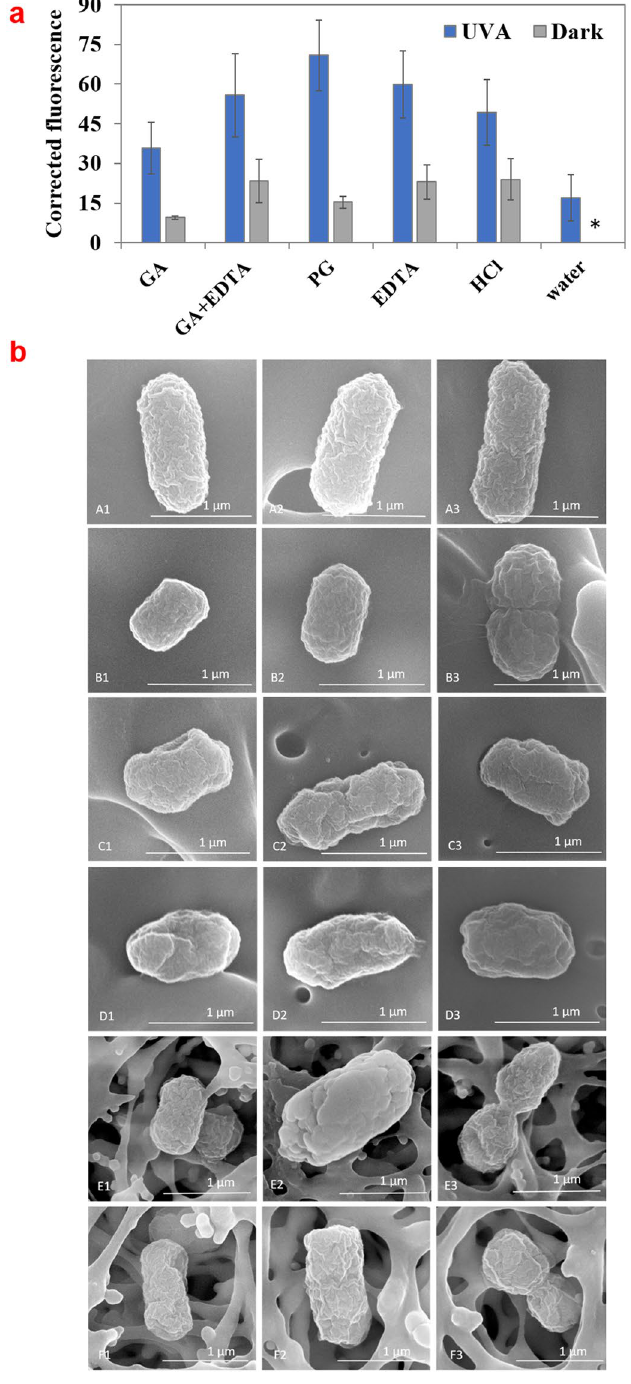
Figure 5. Analysis of cell membrane injury in E. coli O157:H7 treated by UV-A light with select compounds. ( a ) Permeability of E. coli O157:H7 to propidium iodide (PI) after treatment with GA (15 mM), GA (15 mM) + EDTA (1 mM), PG (10 mM), HCl (pH 3.1) or water for 30 min with or without UV-A exposure. Mean ± SD. Absolute fluorescence values were corrected by subtracting the fluorescence values for samples incubated in water and in dark. * Indicates that corrected fluorescence value was zero. ( b ) SEM images showing morphology of E. coli O157:H7 treated for 30 min by (A1-A3) water, (B1-B3) water + UV-A light, (C1-C3) 15 mM GA, (D1-D3) 15 mM GA + UV-A light, (E1-E3) 10 mM PG, (F1-F3) 10 mM PG + UV-A